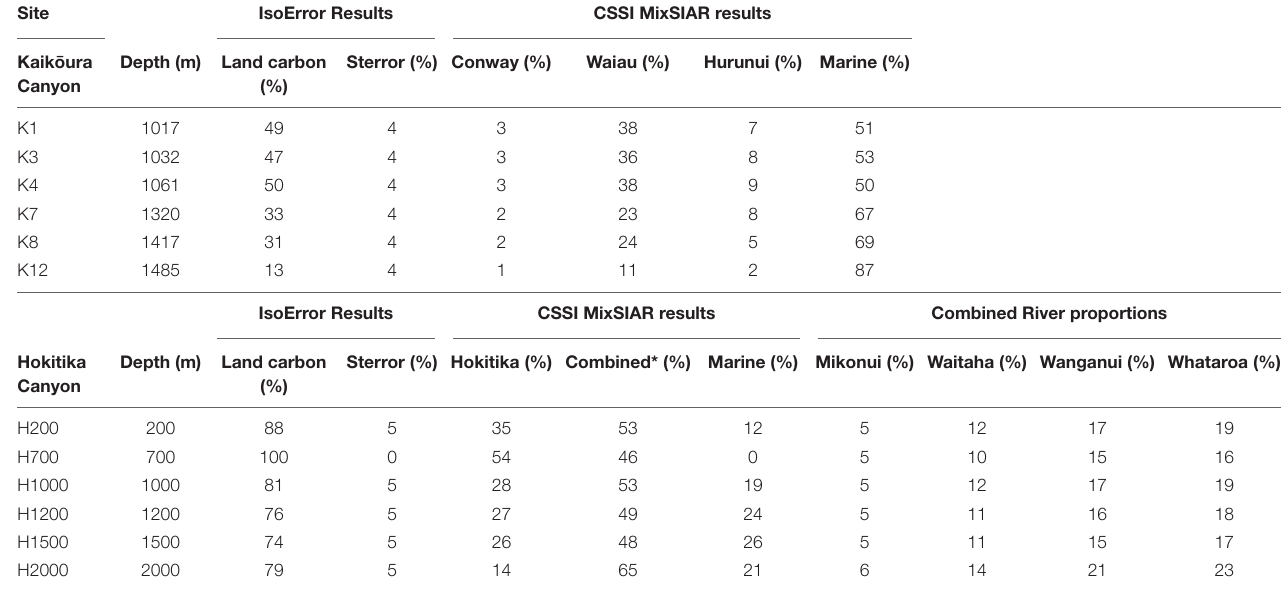
TABLE 4 | Land derived organic matter proportions, derived from IsoError, and source river proportions in that land derived organic matter as estimated by MixSIAR. Site IsoError